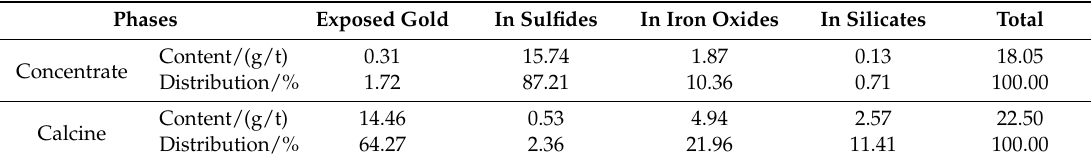
Table 2. Results of chemical phase analyses of Au in gold concentrate and calcine